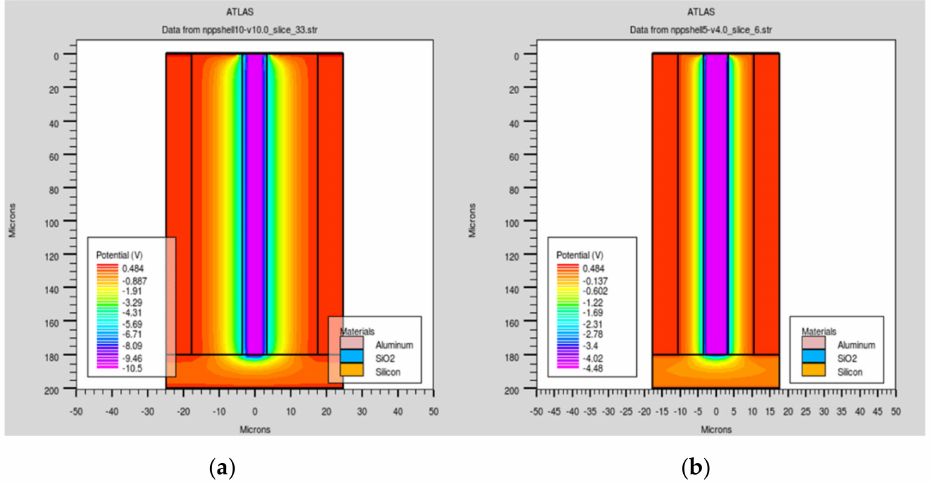
Figure 4. Electric potential profiles along the X–Y diagonal with electrode spacings of ( a ) 10 µ m and ( b ) 5 µ